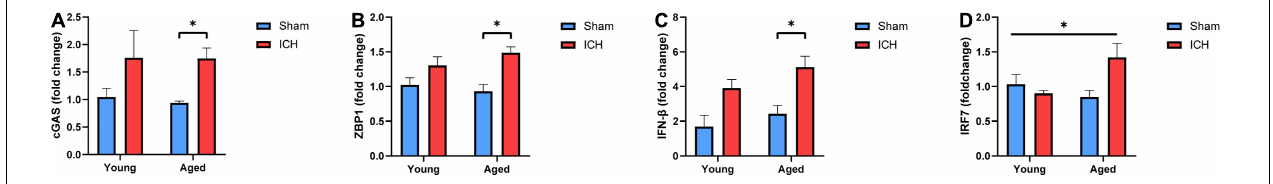
FIGURE 7 | Validation of candidate genes. (A) The mRNA expression levels of Cyclic GMP-AMP synthase (cGAS), (B) Z-DNA-binding protein 1 (ZBP1), (C) Interferon- β (IFN- β ) and (D) interferon regulatory factor 7 (IRF7) were measured by real-time quantitative polymerase chain reaction (RT-qPCR). The mRNA expression is reported as the FC vs. young mice after sham surgery. The data are shown as the mean 2 − (cid:49)(cid:49) CT value ± SEM; young sham: n = 5; young ICH: n = 4; aged sham: n = 4; aged ICH: n = 4; ∗ P < 0.05.